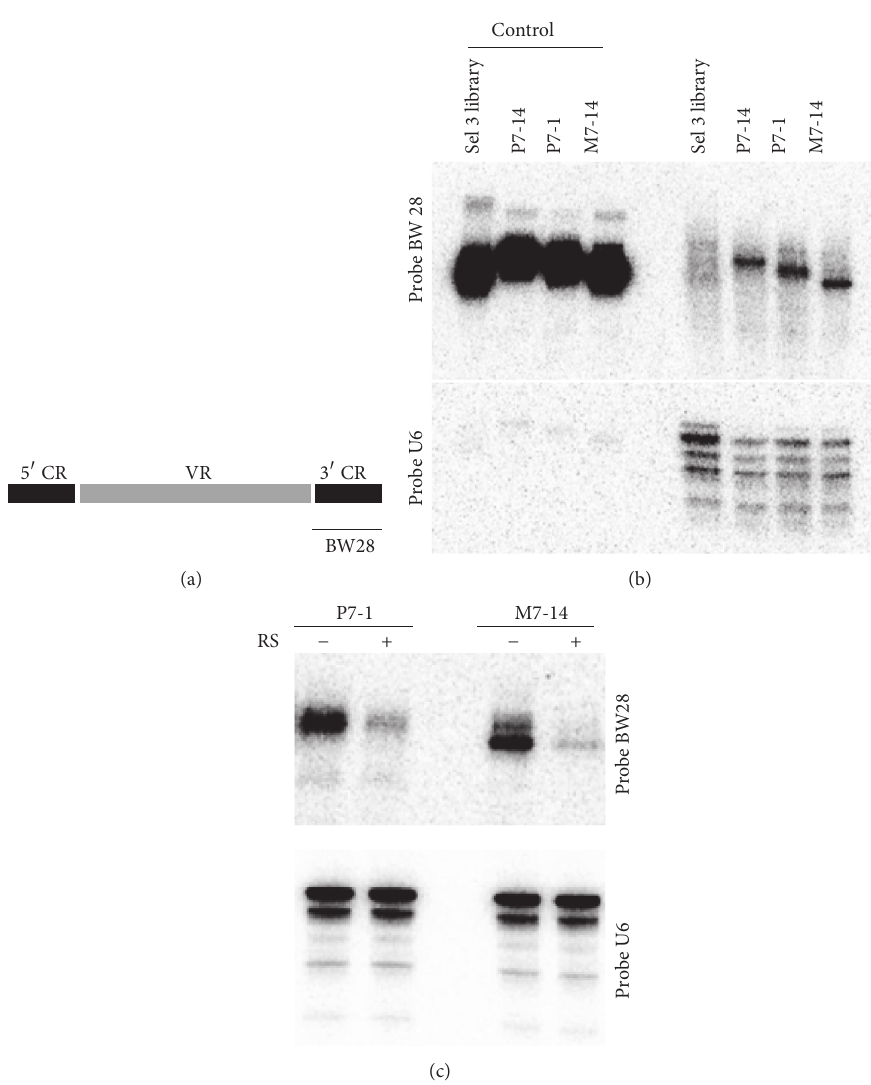
Figure 3: Northern blot analysis of the aptamer clones: (a) 5 󸀠 -[ 𝛾 - 32 P]-radiolabeled probe BW28, complementary to the 3 󸀠 constant region (CR) of the aptamer library, was used for the Northern blot analysis. Variable region (VR). (b) Total RNA (3 𝜇 g/lane), isolated from the MiaPaCa-2 cells after incubating them with the aptamers, were subjected to Northern blot analysis using the 5 󸀠 -[ 𝛾 - 32 P]-BW28 (upper panel). For loading control, the nylon membrane was reprobed with the 5 󸀠 -[ 𝛾 - 32 P]-U6 snoRNA probe (lower panel). Purified aptamers (0.5 𝜇 g/lane) and the starting library (Sel 3) were used as loading controls. Compared to the control (Sel 3 library), P7-14, P7-1, and M7-14 displayed 20, 17, and 24 times more binding to the MiaPaCa-2 cells, respectively. (c) To quantify the percentage of the aptamers internalized in the cells, the total RNA isolated form the MiaPaCa-2 cells after incubating them with the aptamers (P7-1 and M7-14) and with (+) or without ( − ) the RiboShredder (RS) treatment was subjected to the same Northern blot analysis as described above. 10.5% and 27% of the bound M7-14 and P7-1 aptamers were protected from the RS treatment, respectively, due to their internalization in the MiaPaCa-2